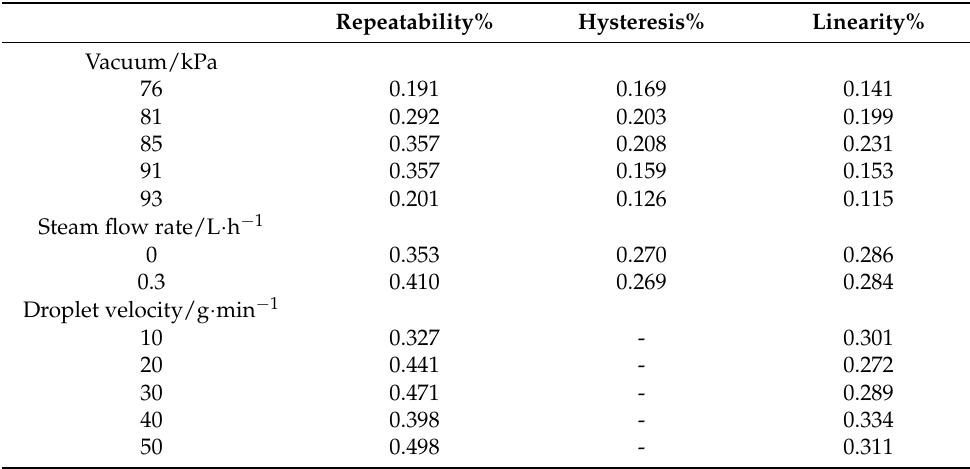
Table 5. Repeatability, hysteresis, and linearity under each experimental